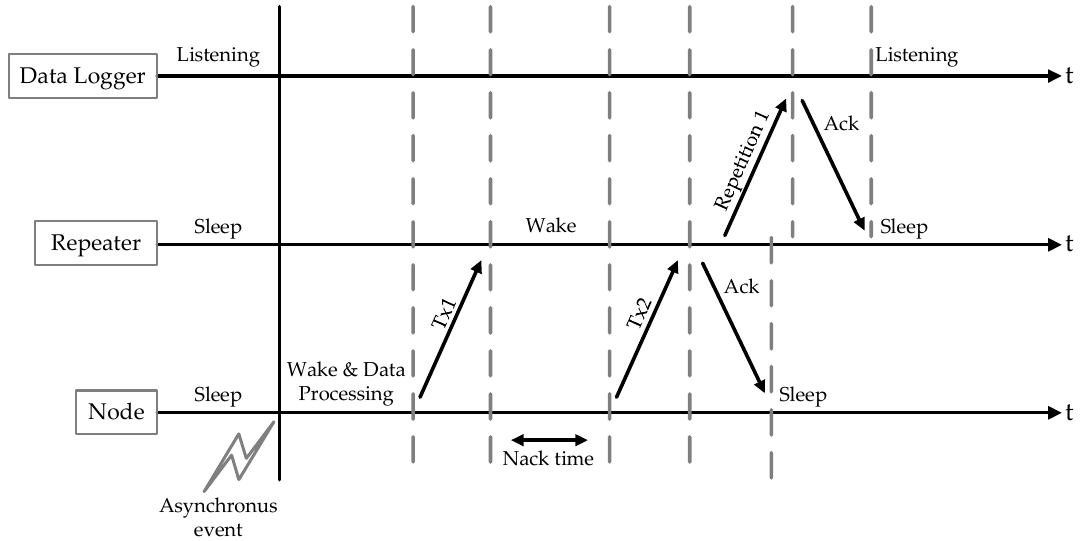
Figure 7. Communication time diagram.